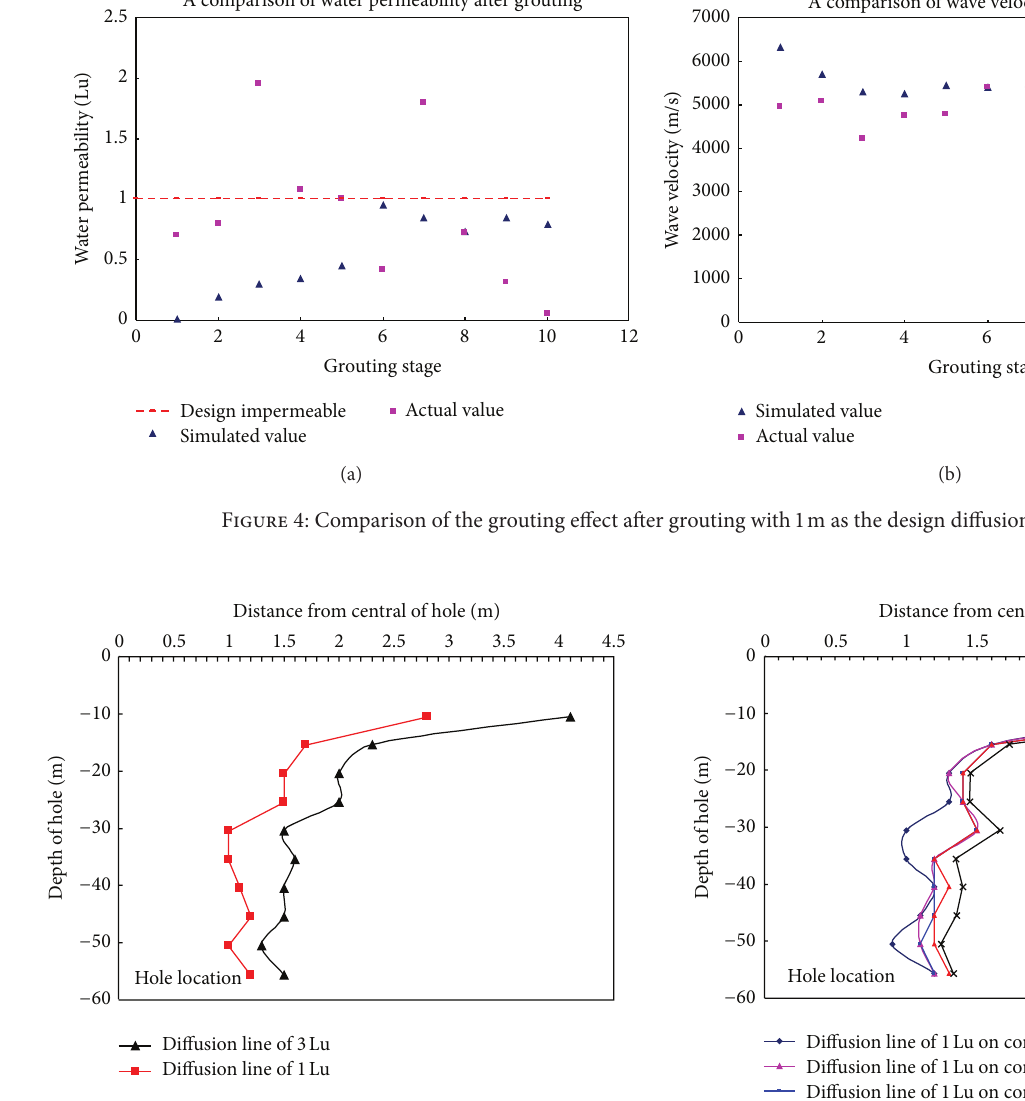
Figure 5: Distribution of the water permeability at different dis- tances.